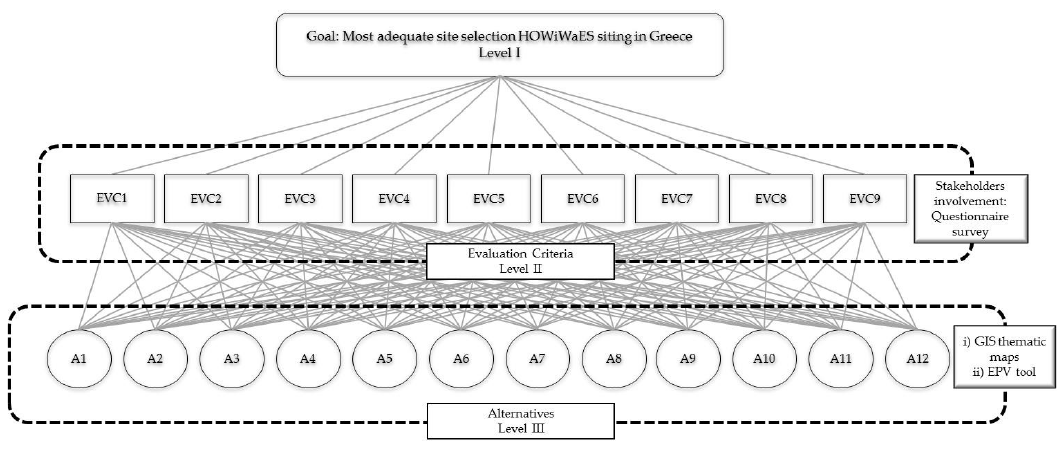
Figure 3. Levels of Hierarchy for selecting the most adequate site for HOWiWaES.